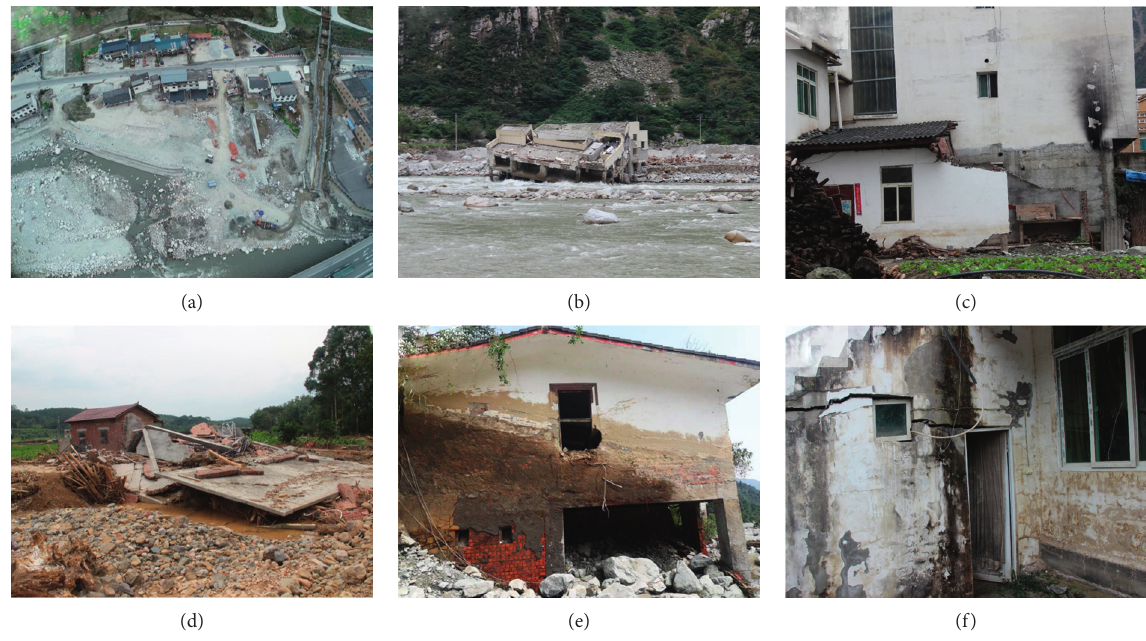
Figure 2: Photographs of damaged buildings due to flash floods in Wenchuan in 2019.